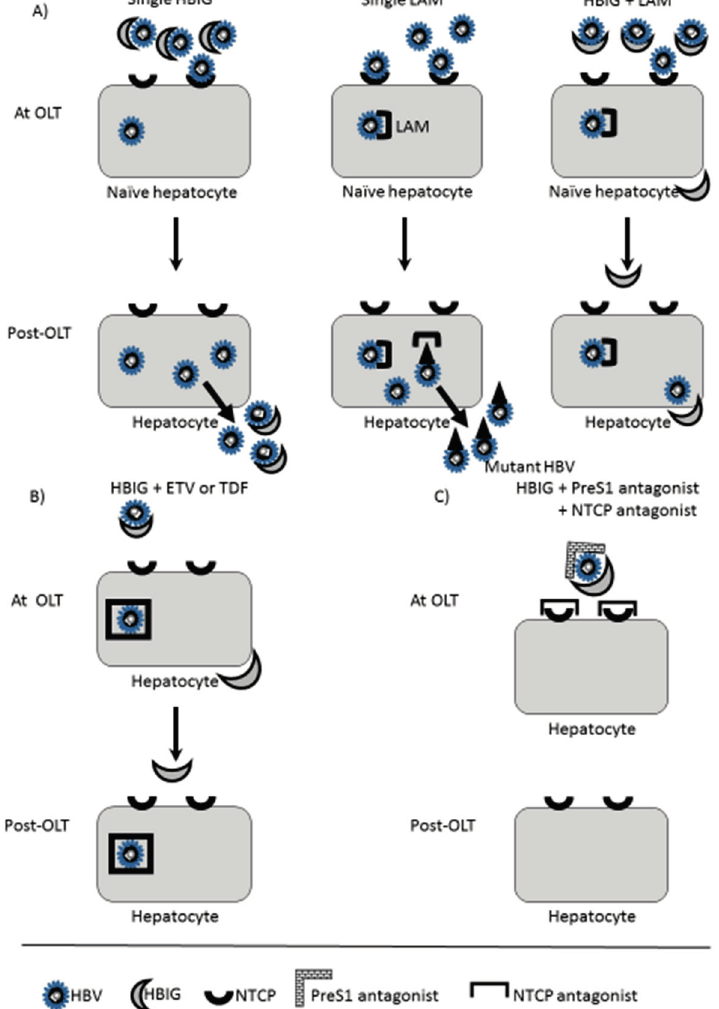
Figure 1. Mechanisms of Hepatitis B Virus (HBV) Prophylaxis after Orthotopic Liver Transplantation (OLT): Past, Present, and Future Perspectives. ( A ) Past: Hepatitis B immunoglobulin (HBIG) single administration or the first-generation nucleoside analogue lamivudine (LAM) resulted in high rates of recurrence. The HBIG and LAM combination controlled HBV recurrence with a relatively high amount of HBIG; ( B ) Present: Since most patients receive newer nuleos(t)ide analogues (NAs) such as entecavir (ETV) or tenofovir (TDF), with very low incidence of viral breakthrough, the HBV viral load before OLT is usually low, and viral control is easier with these drugs. Reductions in the dose of high-cost HBIG have been attempted. HBIG could be used for a short time for pre-OLT negative HBV-DNA patients. The HBV vaccine is good supportive treatment for non-HBV carrier patients and HBV carrier patients with HBV non-tolerated past infected donors or with a lower concentration of calcineurin inhibitors; ( C ) Future: Blocking HBV infection with a combination of HBIG and a PreS1-targeted and NTCP-targeted combination of HBV receptor binding blocking might protect hepatocytes from HBV